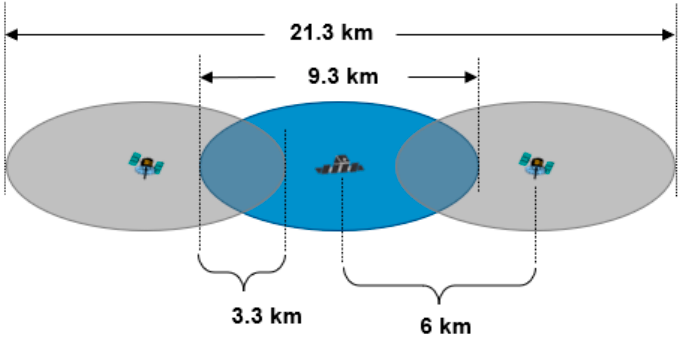
Figure 3. Synthetic aperture length of a multistatic SAR system ( 𝐿 (cid:3020)(cid:3002),(cid:3014)(cid:3020) ). The baseline between each satellite is 6 km, and L SA , MS is 21.3 km. The synthetic aperture length of each satellite is equal to satellite is 6 km, and 𝐿 (cid:3020)(cid:3002),(cid:3014)(cid:3020) is 21.3 km. The synthetic aperture length of each satellite is equal to 9.3 9.3 km, and the overlap is 3.3 km, and the overlap is 3.3 km.